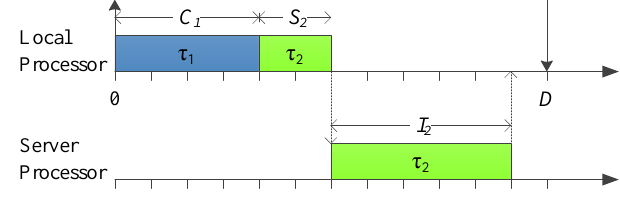
Figure 2 Timing parameters for two